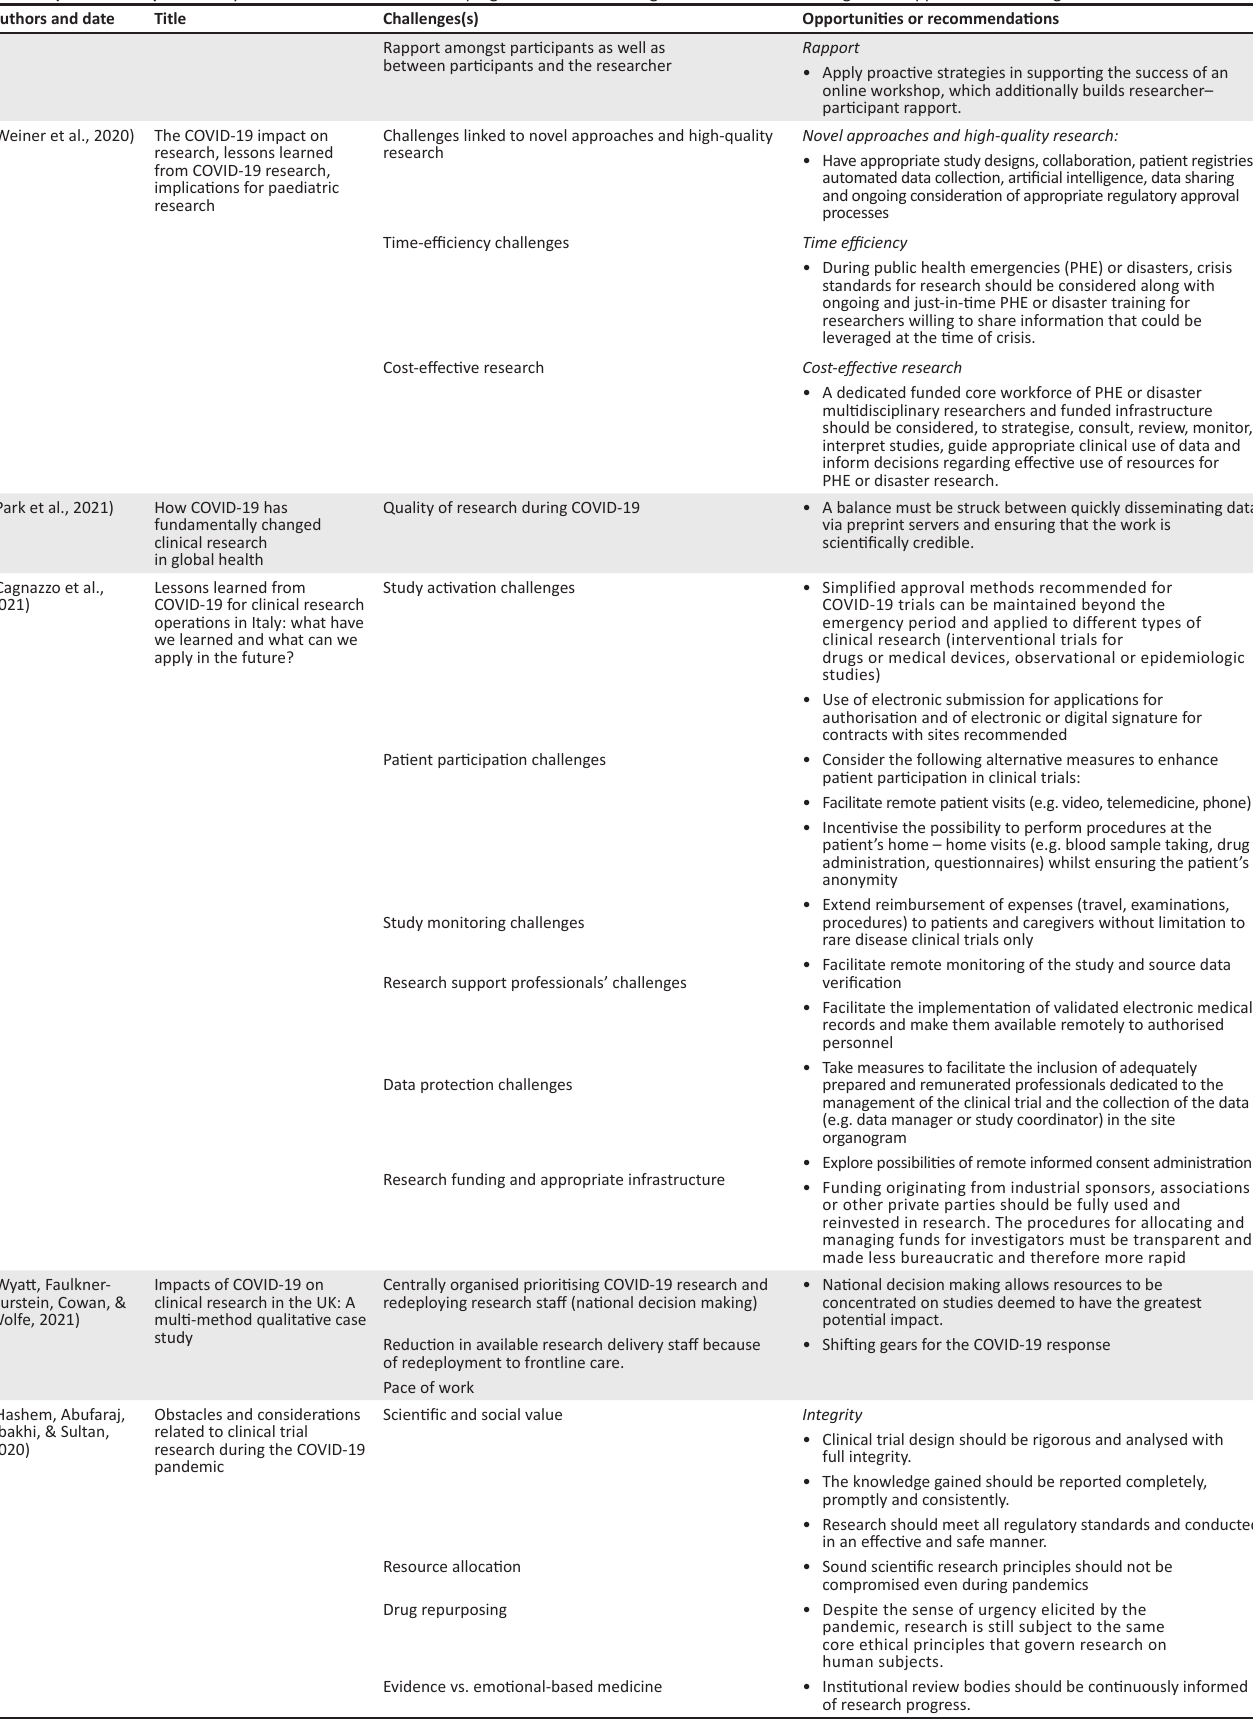
TABLE 1 (Continues...): Summary of studies included in the scoping review documenting clinical research challenges and opportunities during